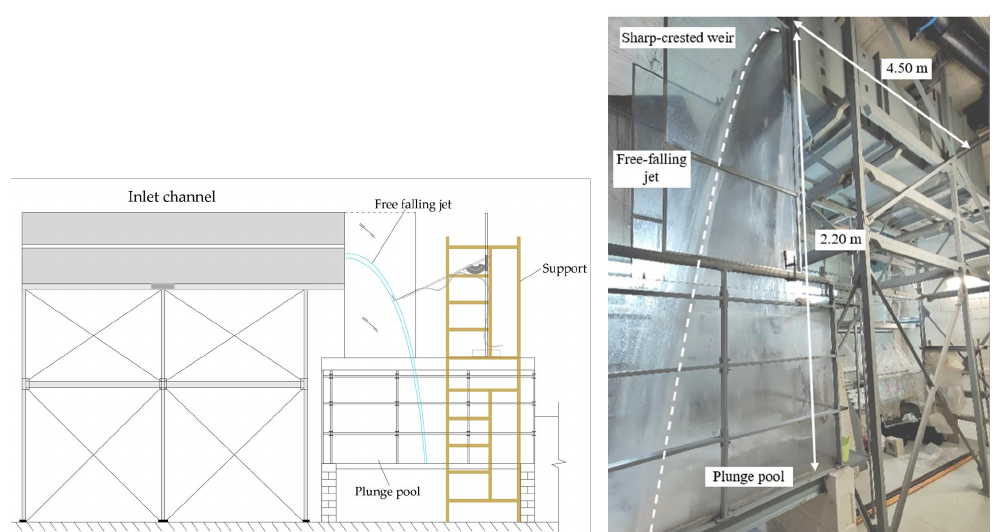
Figure 2. Experimental device of rectangular free-falling jet.